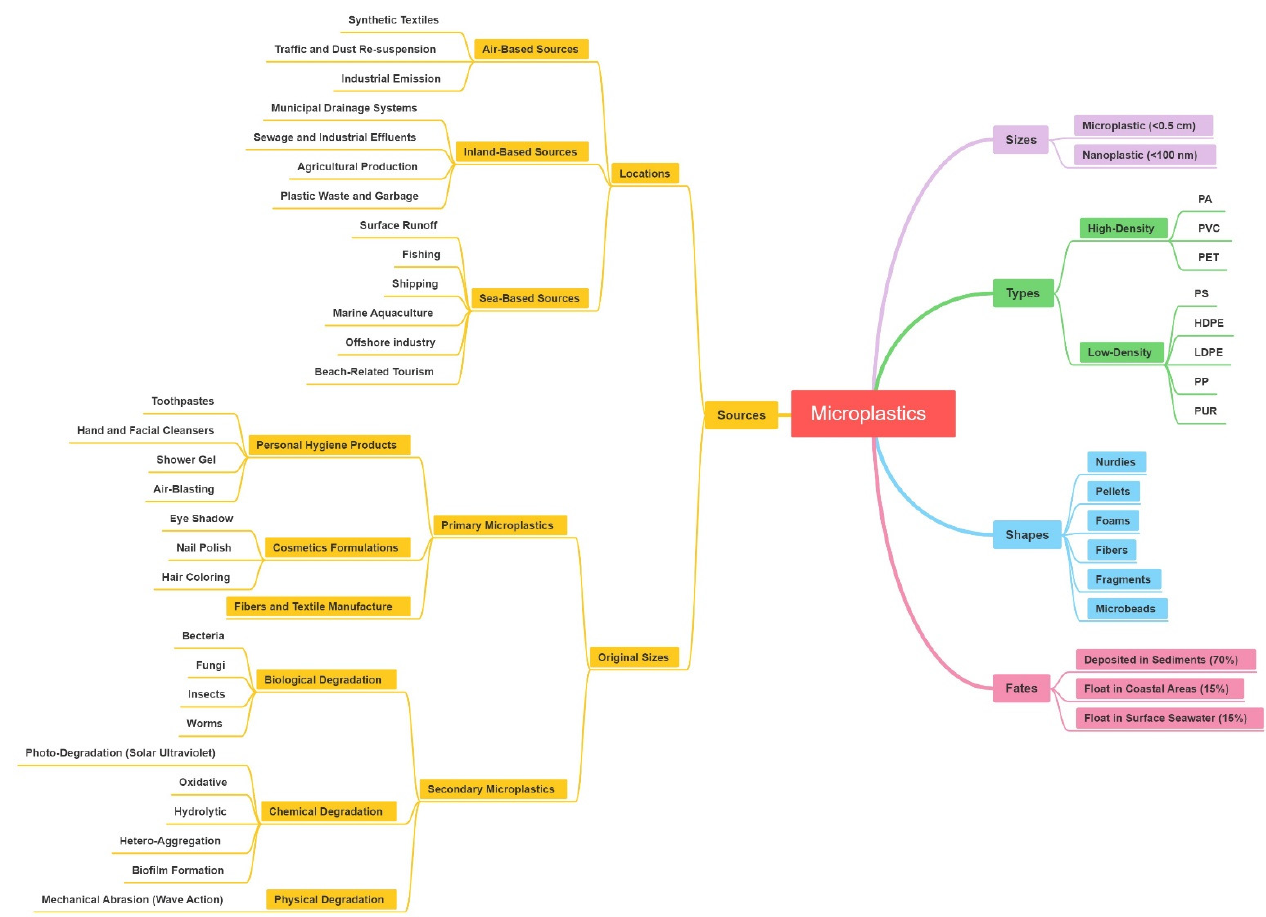
Figure 1. The basic characteristics of microplastic about size, type, shape, source and fate.